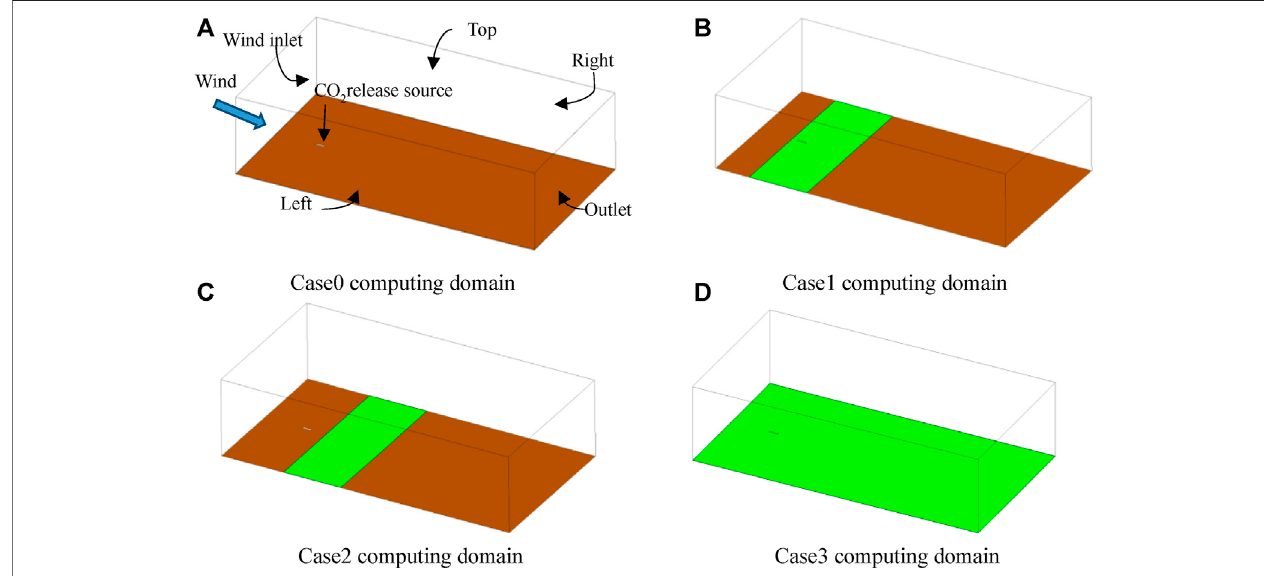
FIGURE 1 | Four cases of computing domain.